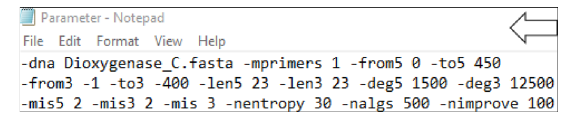
Fig. 5 Screenshot of the command-line parameters used to design the degenerate primer